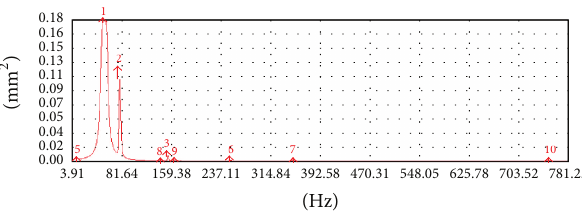
Figure 19: Frequency domain of the wingtip’s dynamic response of a controlled SMA composite wing when the mean wind velocity 𝑉 = 8 m/s.